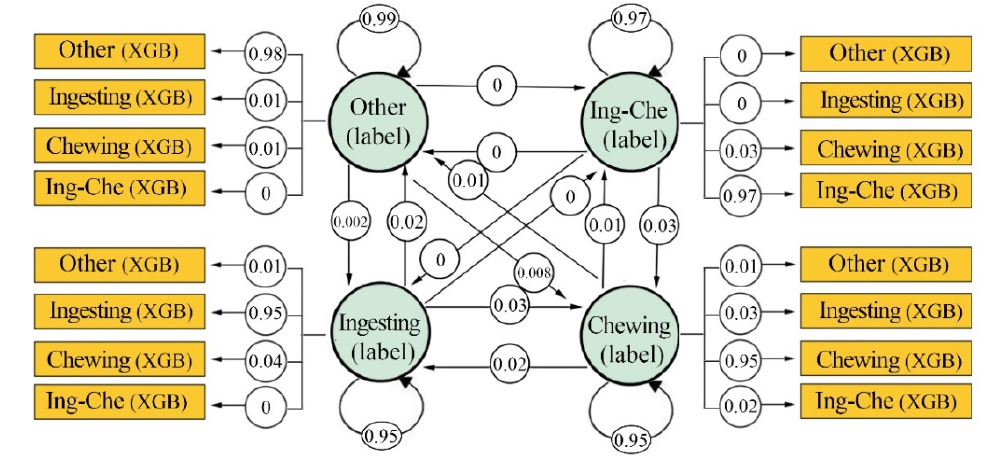
Figure 6. Statistical diagram of state transition probabilities for different activities of feeding behavior (Ing-Che represents ingesting–chewing behavior).